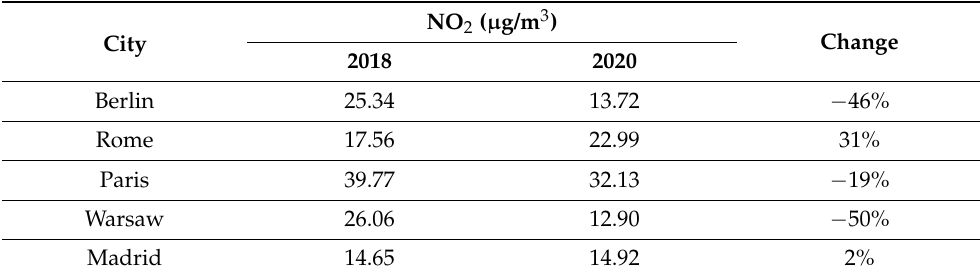
Table 3. Average change in NO 2 concentration on 20 March to 15 April in 2018 and 2020 in selected European